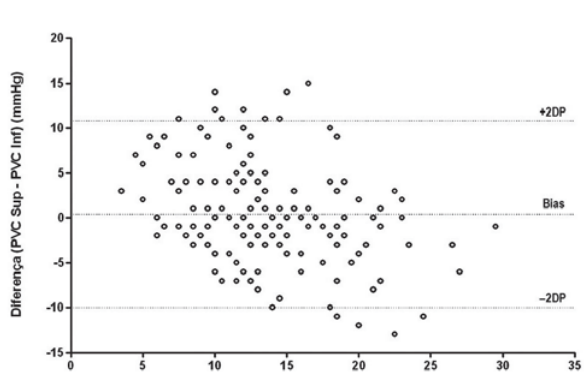
Fig. 3 - Média da PVC superior vs. inferior em inclinação de zero grau. Gráfico de Bland-Altman mostrando a média da diferença entre a pressão venosa central superior e femoral (Bias) em inclinação da cabeceira do leito em zero grau; –1,9 mmHg com limite de concordância 95% (representado por ± 2DP) de –10,3 a 6,5 mmHg. DP – desvio padrão